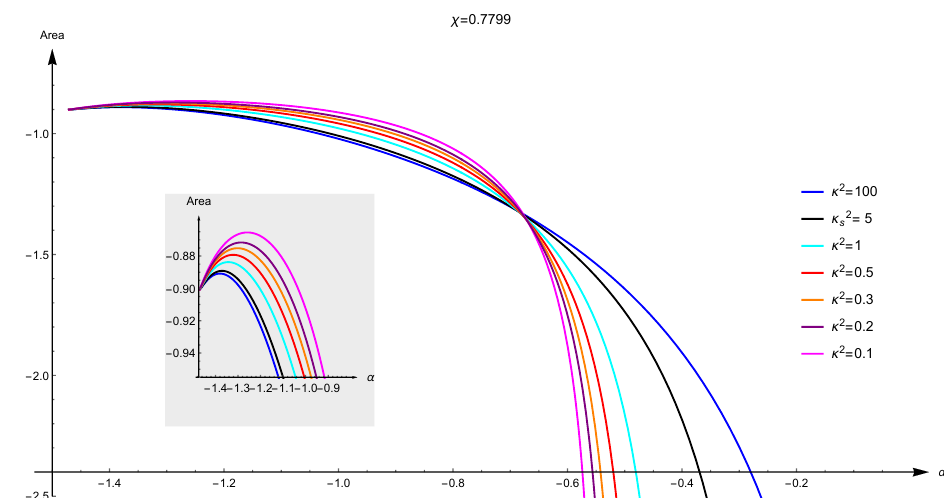
Figure 10. We have plotted the behaviour of the area as a function of (cid:11) = arctan( m ) for a value of the angle above (cid:31) s and for di(cid:11)erent values of the (cid:13)ux. Independently of (cid:20) 2 all the curves terminate on the same point ( m 0 ; (cid:31) 0 = (cid:25) (cid:0) K ( m 0 )) and display a maximum. On the left we have zoomed in 2 the region close to m 0 to show the presence of a maximum value for the area.